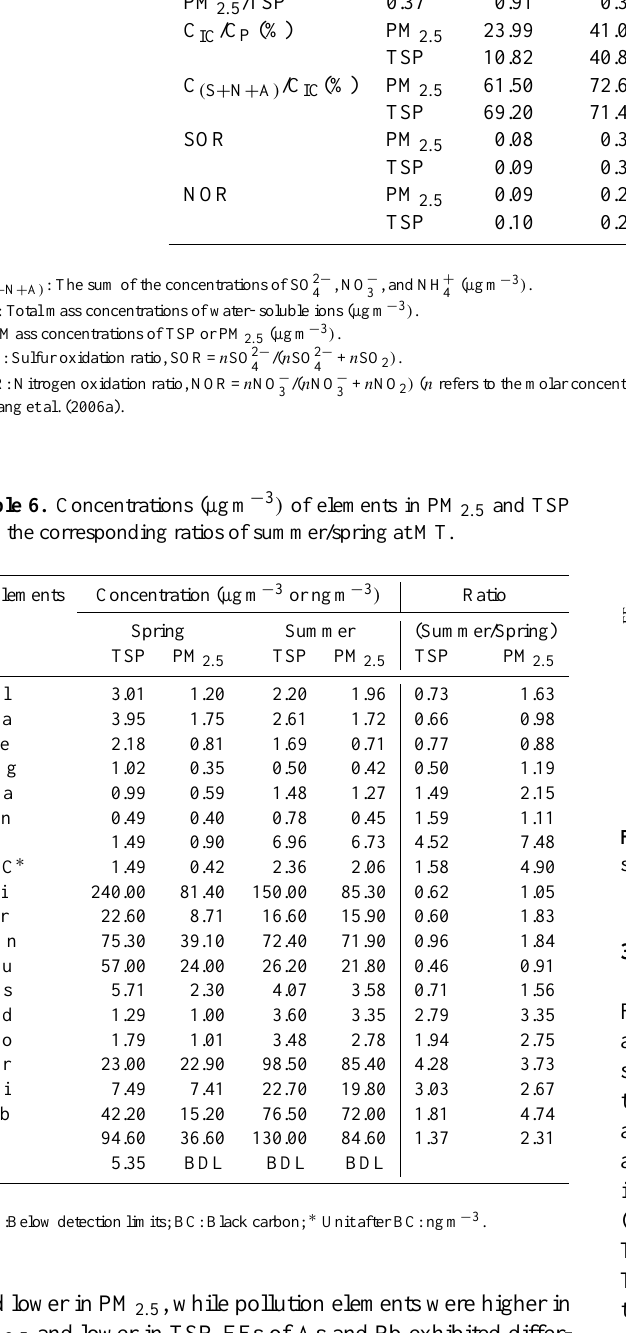
Table 5. SOR, NOR of ambient air and main water-soluble ions in PM 2 . 5 and TSP at MT and Beijing. MT Beijing ∗